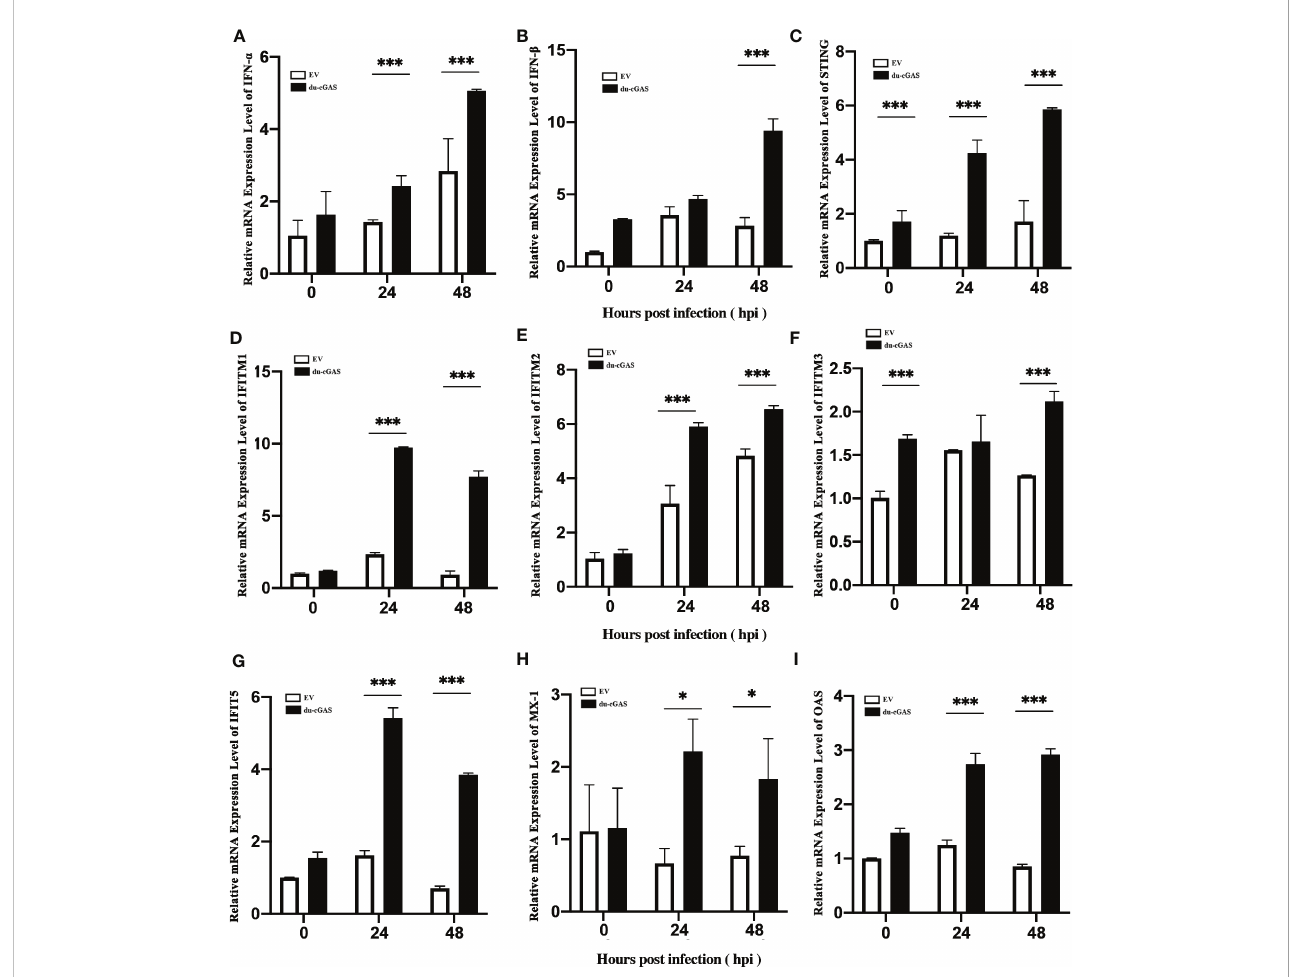
FIGURE 6 Activation of IFNs, STING, and key ISGs expression by du-cGAS overexpression. DEF cells expressing du-cGAS and EV were infected with DAdV B2 at the MOI of 1.0 and harvested at indicated time points (24 and 36 hpi). The qRT-PCR was used to detect the relative mRNA expression levels of type I IFNs, STING, and key ISGs. (A) IFN- a ; (B) IFN- b (C) STING; (D) IFITM1; (E) IFITM2; (F) IFTIM3; (G) IFIT5; (H) Mx1; (I) OAS. Data represent the mean values ± SD, and statistical signi fi cance was analyzed by t-test. * P < 0.05, ** P < 0.01, *** P <